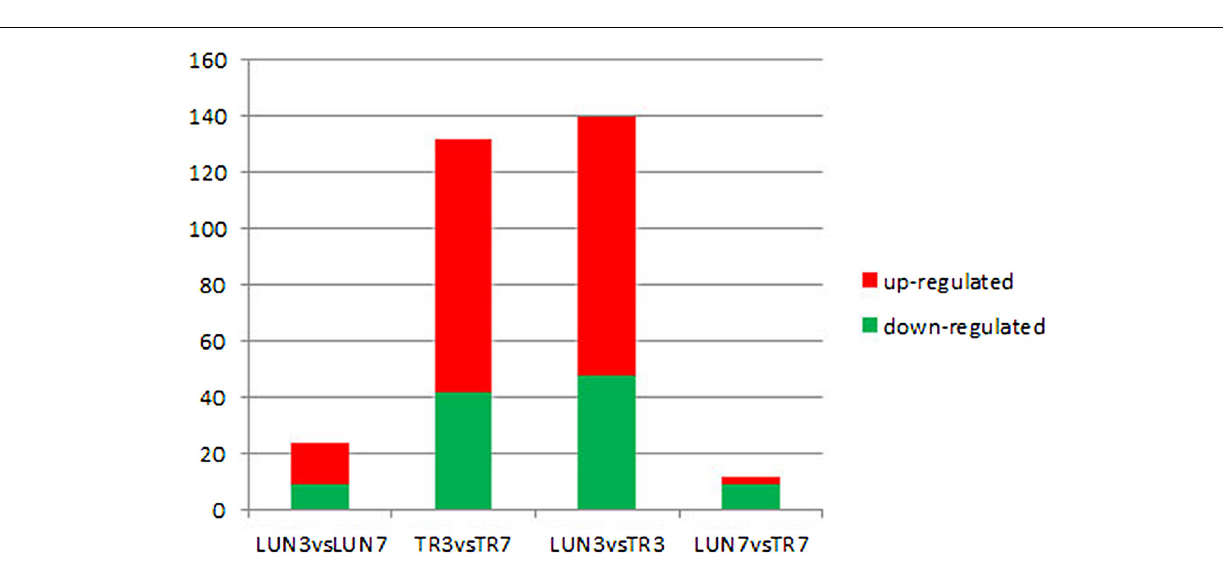
Frontiers in Microbiology |